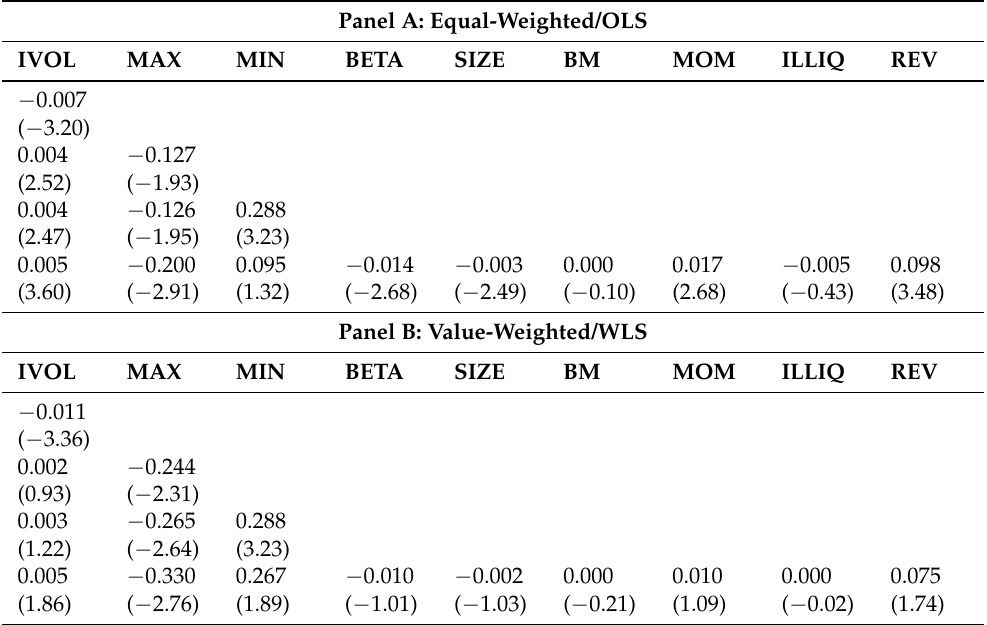
t-statistics in parenthesis, of firm-level OSL and WLS regressions. The dataset comprises time periods between 1998 and 2016 when the Brent oil market was